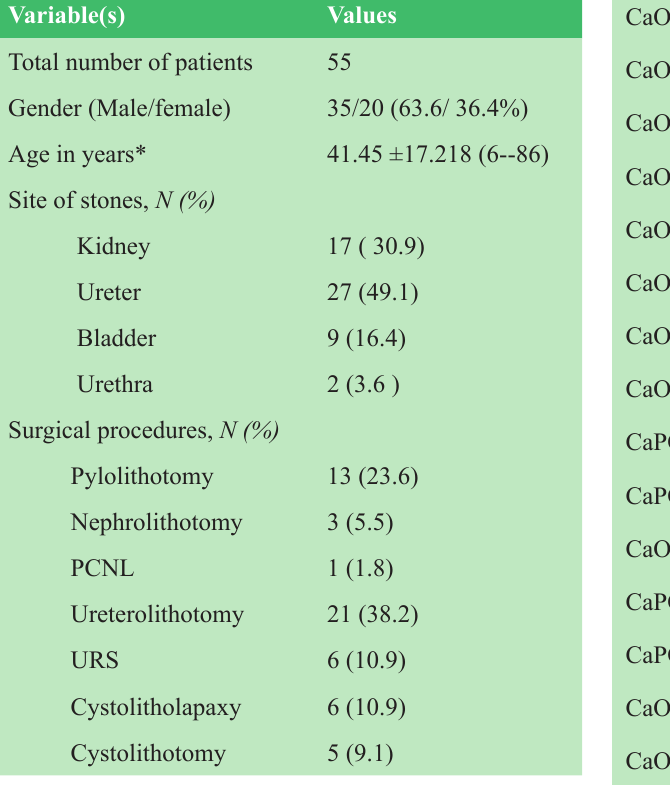
Table 1: Demographics and stone related variables